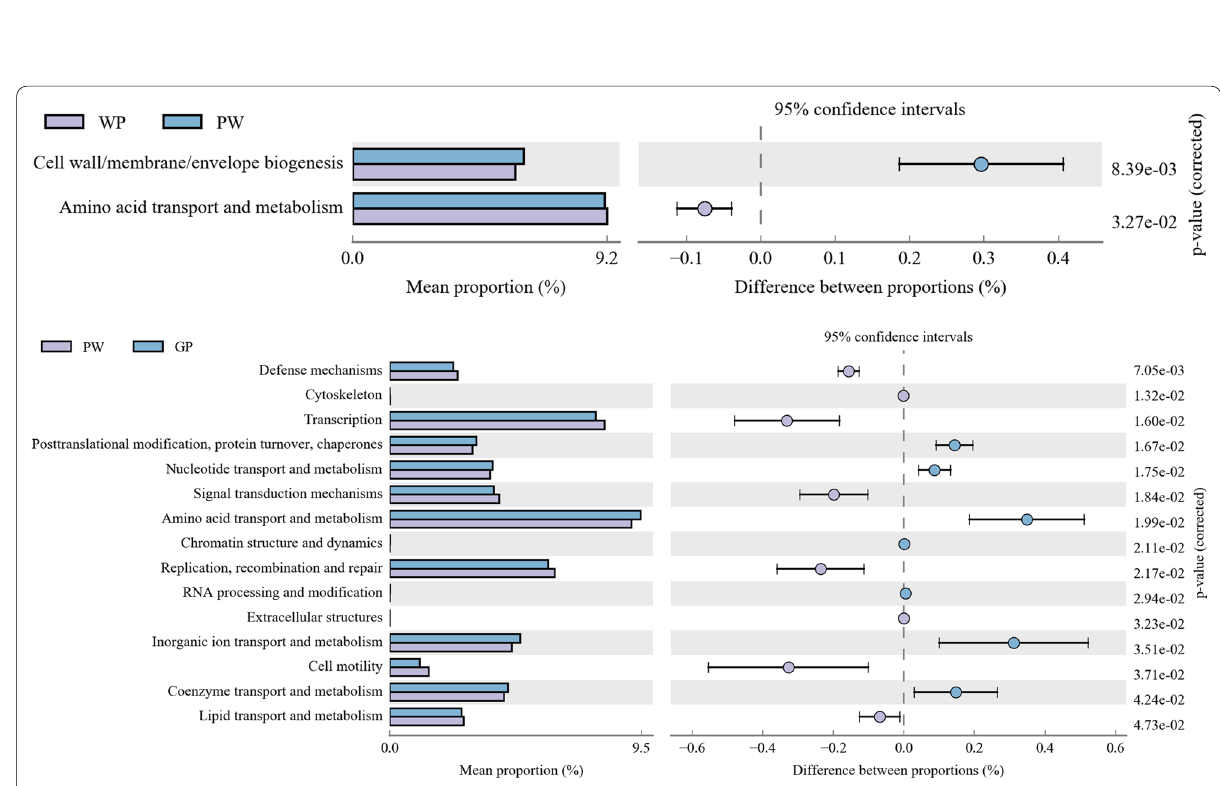
Fig. 4 Comparison of COG functions in fecal microbiota of pigs at different grow stages. Proportion of functional abundance differences within the 95% confidence interval. COG, Clusters of Orthologous Groups of